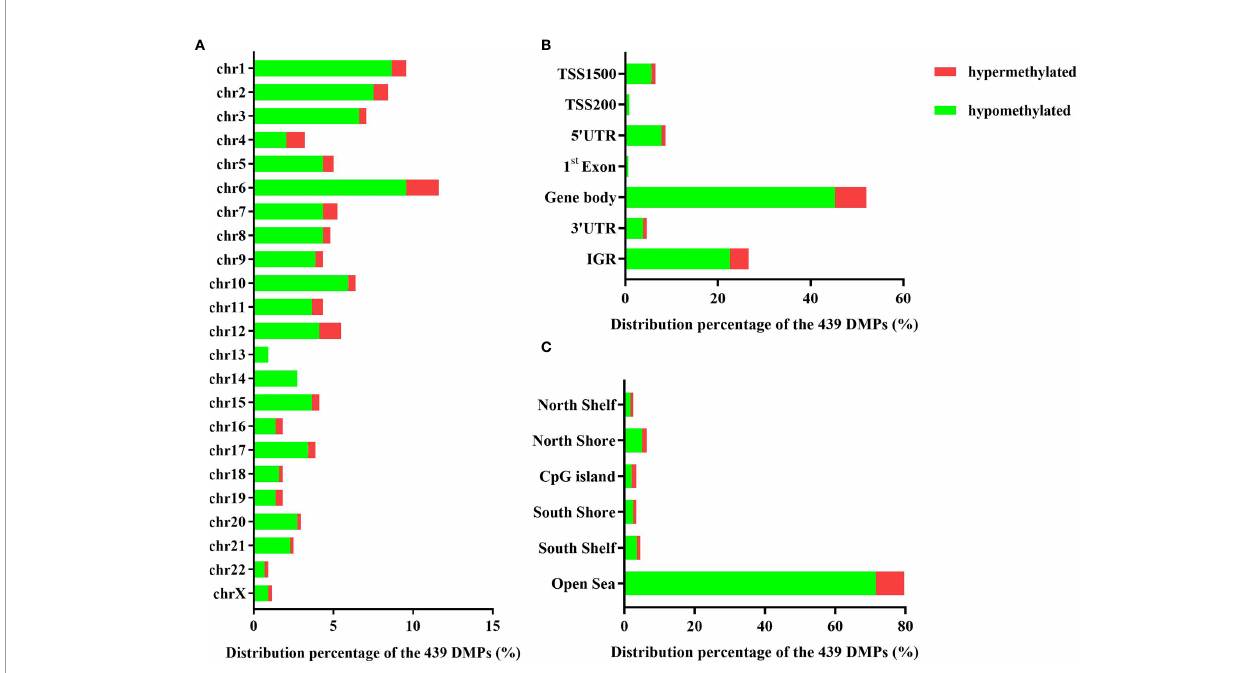
FIGURE 4 | (A) The distribution percentages of the 439 differentially methylated positions (DMPs) on different chromosomes. (B) The distribution percentages of the 439 DMPs on different gene regions including TSS1500, TSS200, 5 ’ UTR, 1st Exon, gene body, 3 ’ UTR, and intergenic regions (IGR). The red bars represent hypermethylated DMPs whereas the blue bars represent hypomethylated DMPs. (C) The distribution percentages of the 439 DMPs in different CpG island regions including North Shelf, North Shore, CpG island, South Shore, South Shelf, and Open Sea.